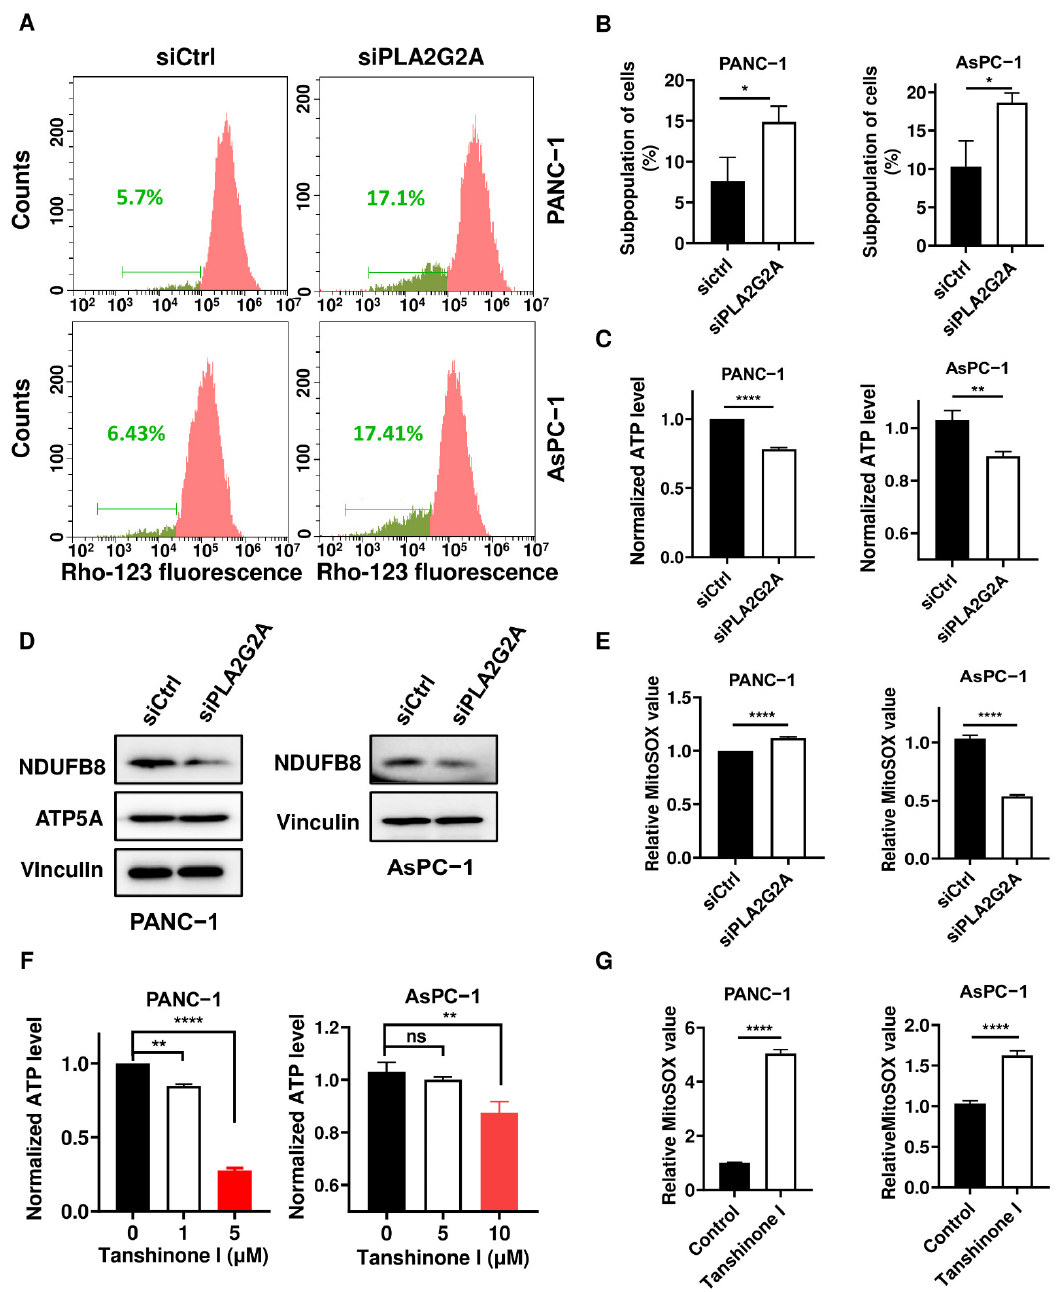
Figure 6. Inhibition of PLA2G2A induces mitochondrial dysfunction in PDAC cells. ( A , B ) Effect of PLA2G2A knockdown by siRNA on mitochondrial transmembrane potential. PANC-1 and AsPC-1 cells were transfected with 50 nM siRNA against PLA2G2A for 72 h and then stained with potential- sensitive chemical probe Rhodamine - 123 followed by flow cytometry analysis. The green numbers indicate the subpopulation of cells that lost transmembrane potential in the respective samples. ( C )